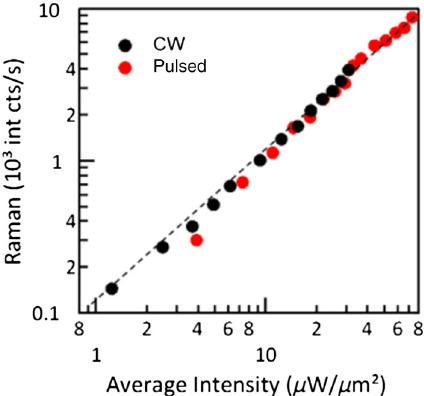
FIG. 5. Raman intensity of a silicon sample, as a function of excitation power for both CW and pulsed 633-nm excitations. Raman signal is plotted as a function of average laser intensity.